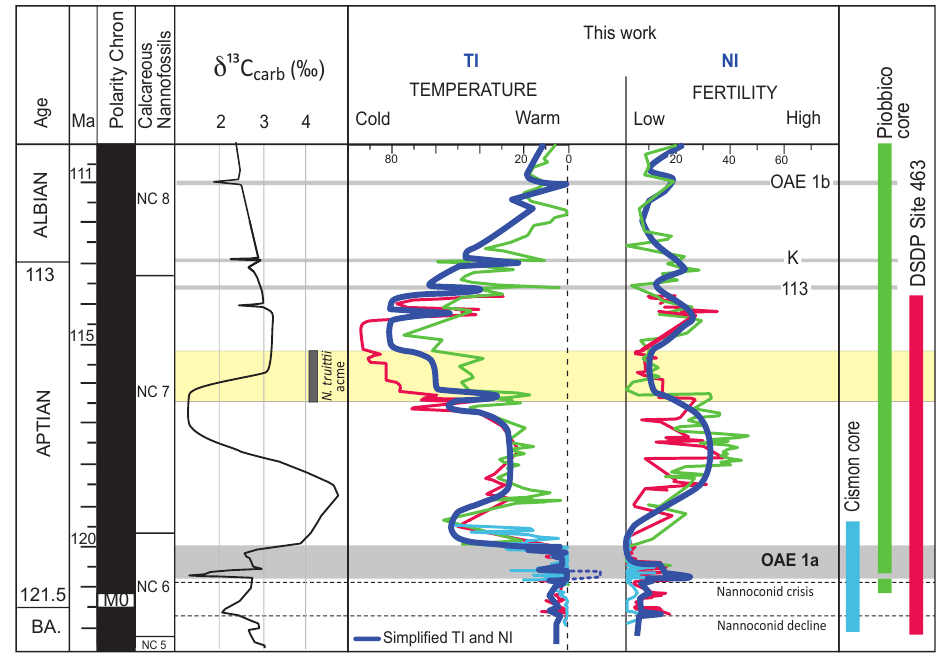
Figure 6. Composite nannofossil TI and NI curves extrapolated from the three-point moving averages of the TI and NI in the three studied sections for the Aptian including the Aptian–Albian boundary interval (this work) and the earliest Albian (from Tiraboschi et al., 2009). The dashed TI spike in the earliest part of OAE 1a takes into account the relative abundance of R. asper , showing a maximum at this level. Bio-chemo-magneto stratigraphy after Erba et al. (2015). Numerical ages are based on the timescale of Malinverno et al.